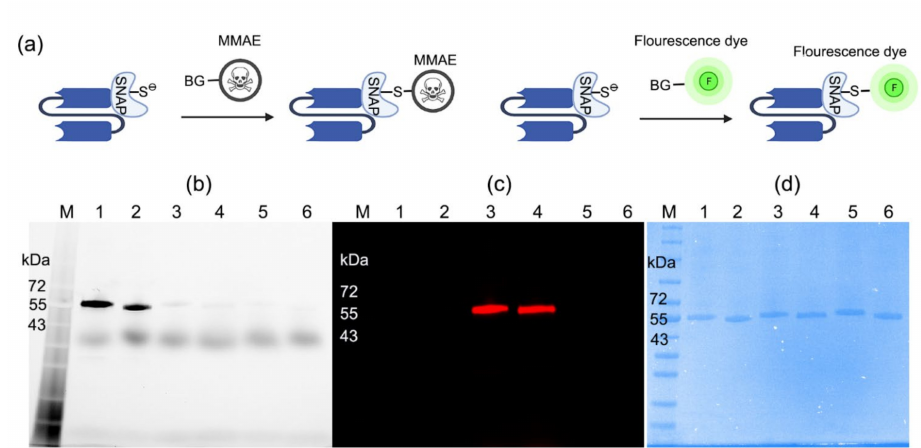
Figure 1. Conjugation of scFv-SNAP fusion proteins with BG-modified agents. ( a ) Schematic diagram of conjugation. ScFv-SNAP fusion proteins conjugated with SNAP-Surface ® Alexa Fluor ® 488 and visualized with ChemiDoc XRS+ System ( b ) or SNAP-Surface ® Alexa Fluor ® 647 visualized with Odyssey DLx Imager ( c ). ( d ) Corresponding Coomassie brilliant blue stain of SDS-PAGE. M: Blue prestained protein standard broad range (11 − 250 kDa). Lanes 1–2: scFv-425-SNAP and scFv-EpCAM- SNAP were incubated with SNAP-Surface ® Alexa Fluor ® 488. Lanes 3–4: the same proteins were labeled with SNAP-Surface ® Alexa Fluor ® 647, and were post-incubated with SNAP-Surface ® Alexa Fluor ® 488. Lanes 5–6: the same proteins were labeled with BG-MMAE, and were post-incubated with SNAP-Surface ® Alexa Fluor ® 488.